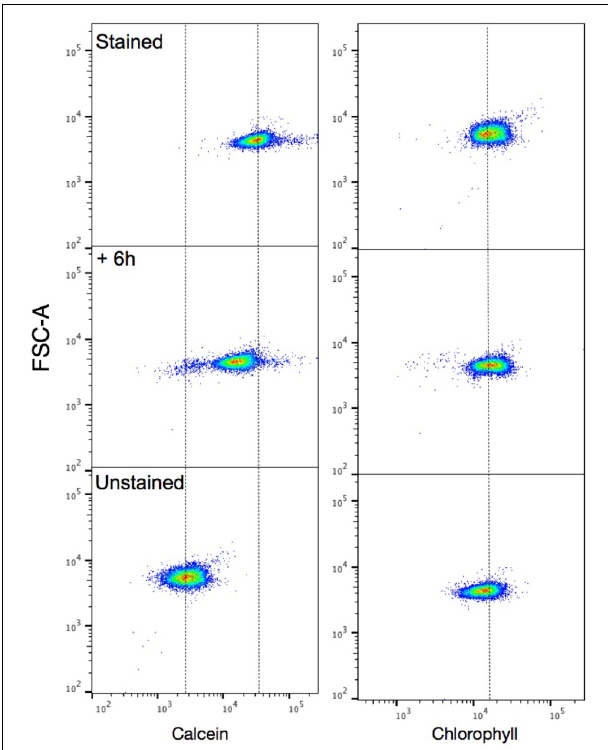
FIGURE 10 | Tracking of calcification in Emiliania huxleyi using flow cytometry. Intensity dot plots of calcein (Left) and chlorophyll (Right) signals vs. forward scatter (FSC-A) for stained E. huxleyi cells. From top; stained, +6 h, and unstained cells showing a shift in the +6 h population toward an unstained signature. 10,000 events were collected and a threshold on the chlorophyll channel was used to exclude collection of detached coccoliths. Dotted lines are used for reference on each